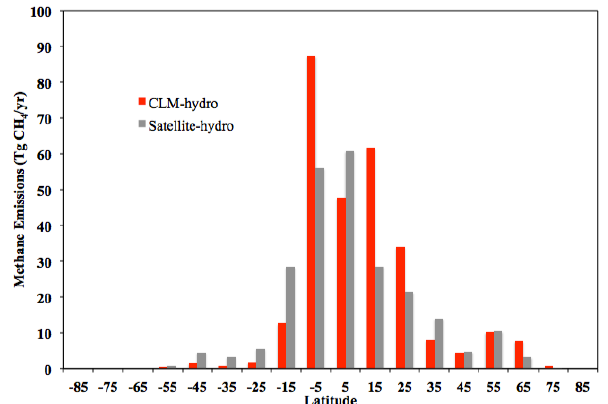
Fig. D. Latitudinal distribution of methane emissions simulated in the CLM. CLM-hydro 2" Fig. D1. Latitudinal distribution of methane emissions simulated in indicates simulations with CLM-derived hydrology (i.e., fully coupled with CLM hydrology) 3" the CLM. CLM-hydro indicates simulations with CLM-derived hy- while Satellite-hydro used satellite inundated fraction to drive methane model. CLM-hydro 4" estimated a peak of methane emissions in the Southern Hemisphere and Satellite-hydro produced 5" drology (i.e., fully coupled with CLM hydrology), while Satellite- maximum methane emissions in the Northern Hemisphere. 6" hydro used satellite inundated fraction to drive methane model. CLM-hydro estimated a peak of methane emissions in the South- ern Hemisphere, and Satellite-hydro produced maximum methane emissions in the Northern